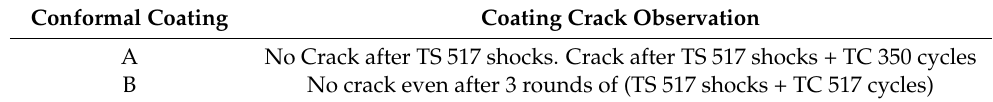
Table 10. Conformal coating reliability test.